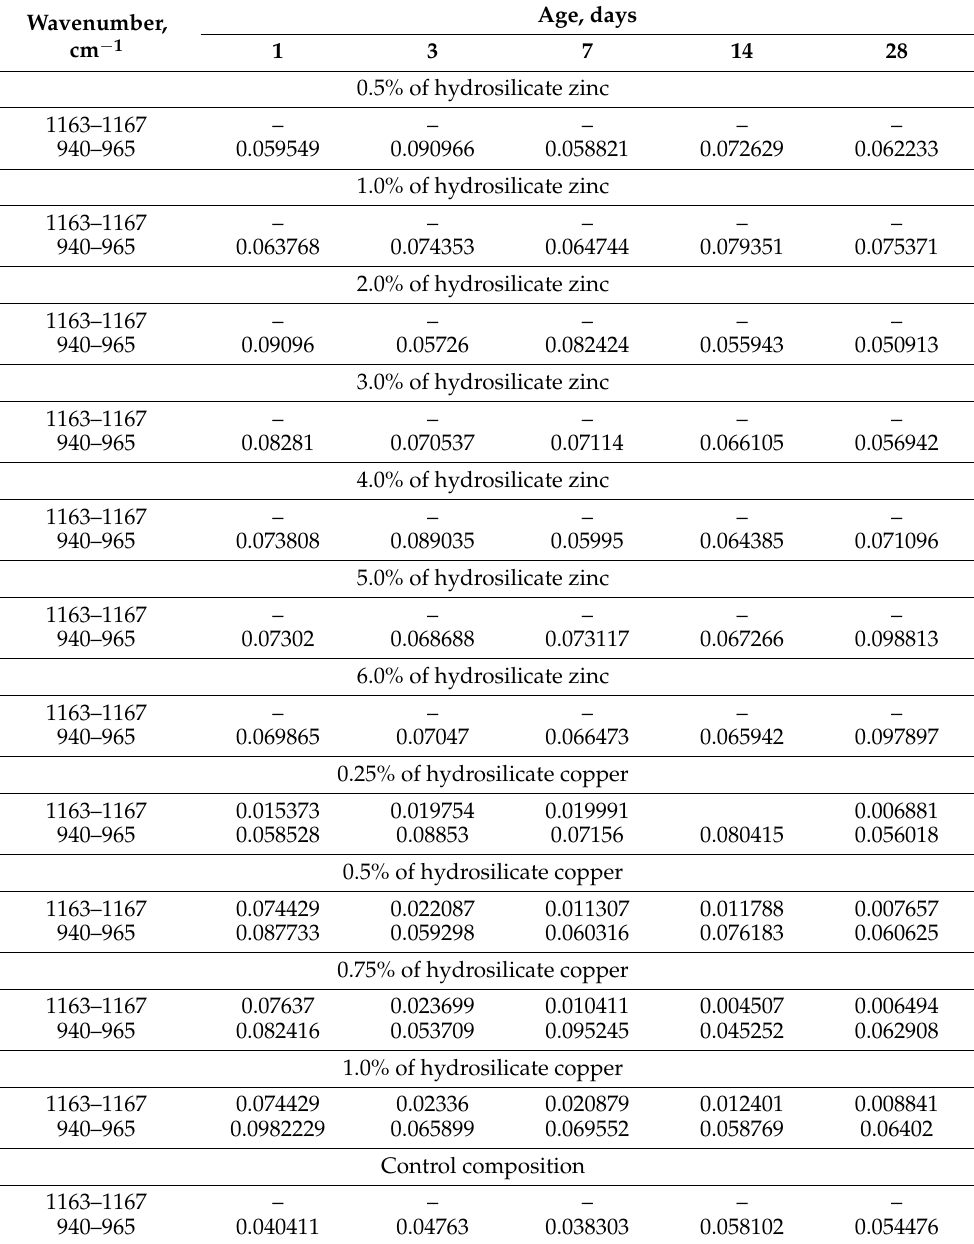
Table 2. Intensity of IR